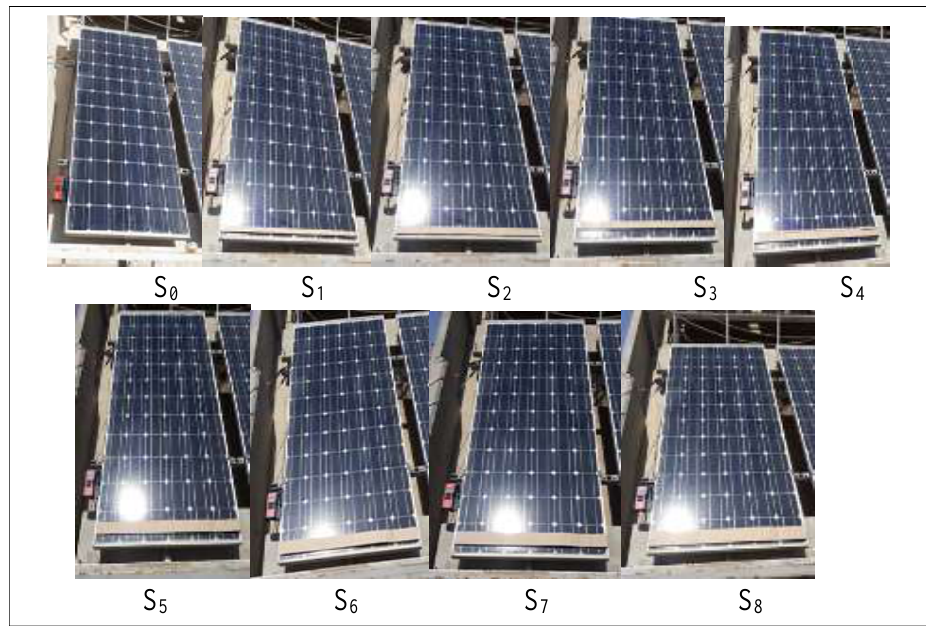
Figure 3. Photos of the shade at 12